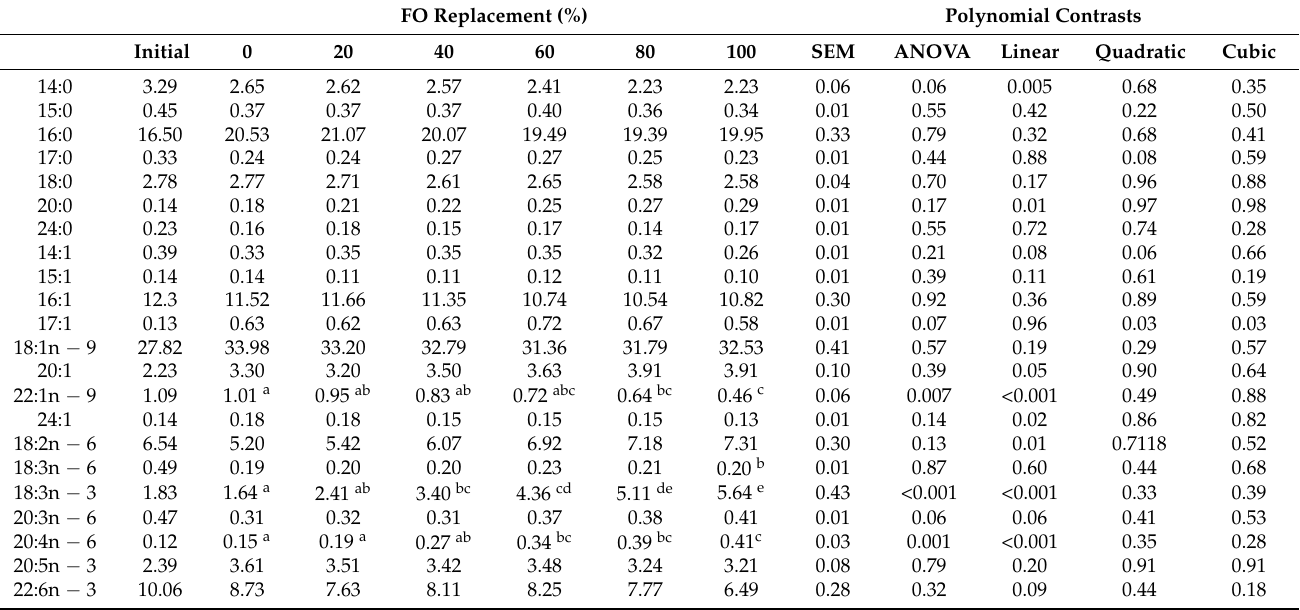
Table 7. Fatty acid profile (% of lipids) of the whole body of juvenile tench fed practical diets with different replacements of cod liver oil (FO) with camelina oil